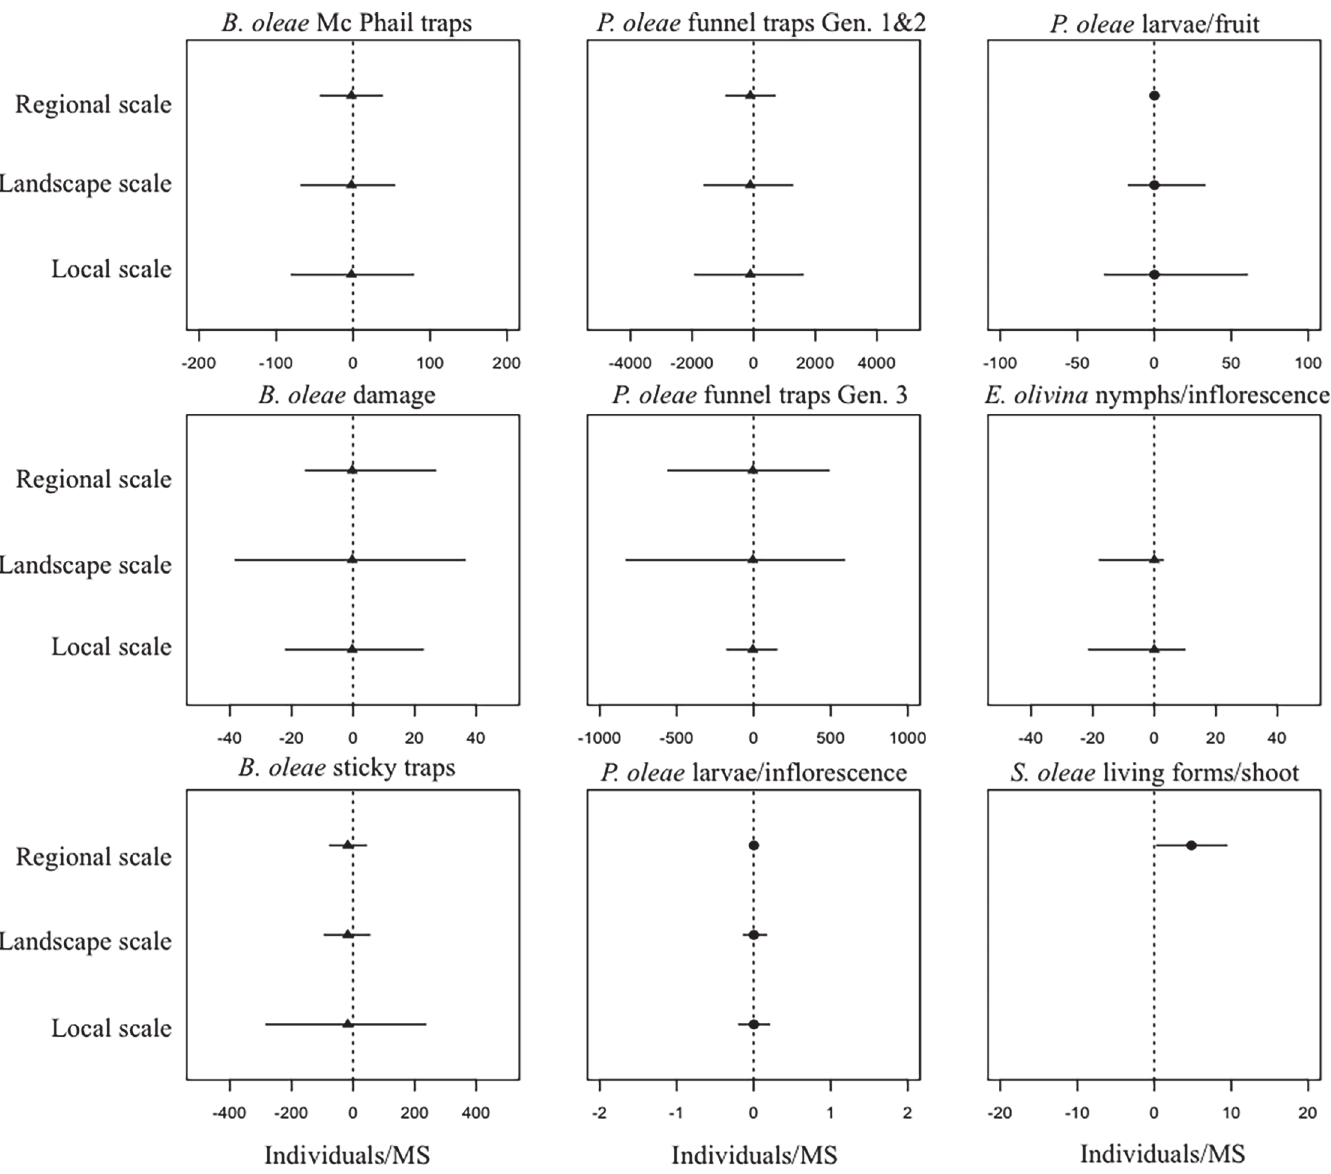
Figure 2. Best model estimations for the differences between ground cover and bare soil for all the response variables. Positive values represent an increase in pest abundance in the presence of ground cover (filled circle) whereas negative values represent a decrease in pest abundance in the presence of ground cover (filled triangle). Bars represent a 95% of the confidence interval of the random effects predictions ( ± σ 2 ) at a local, landscape, and regional scale. If a random factor is not included in the selected best model (Table 2), no 95% confidence interval bars were